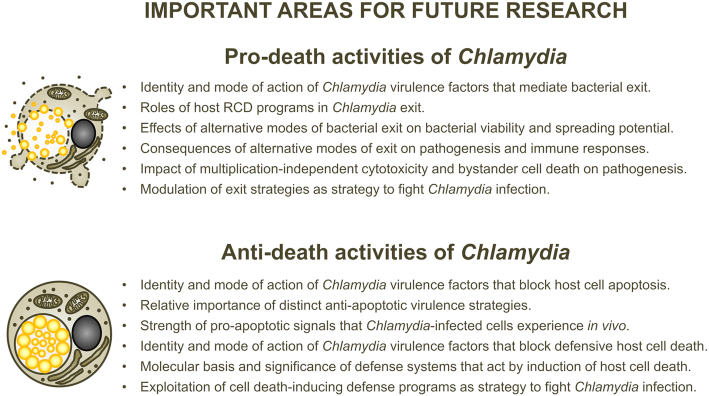
Important areas for future research. This figure gives an overview of highly relevant questions that need to be addressed in depth in the future.